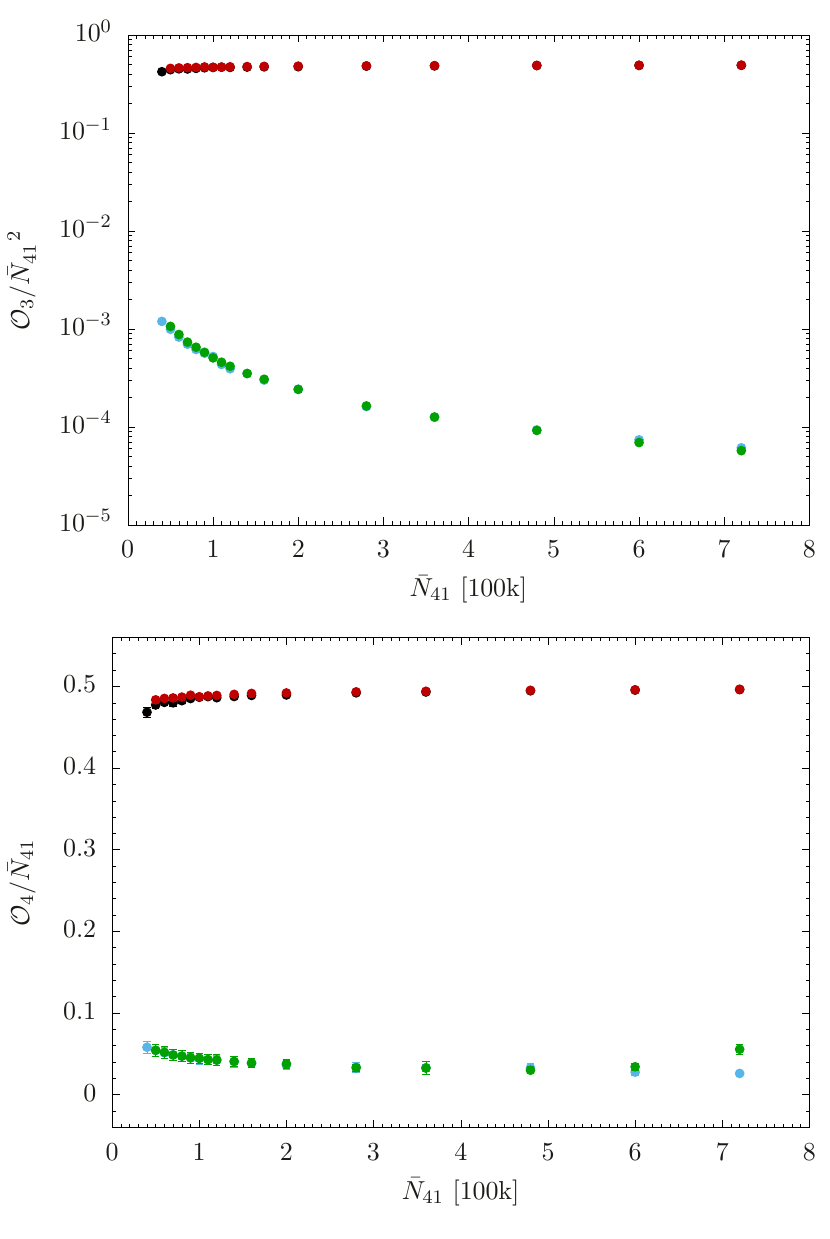
and O 4 = (cid:22) N as a function of (cid:22) N 41 at the endpoints of the 41 41